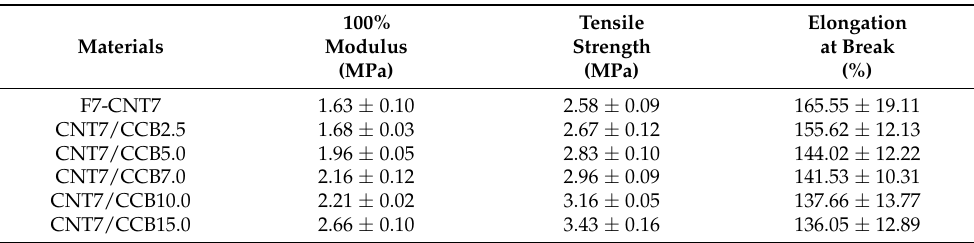
Table 3. Tensile properties in terms of 100% modulus, tensile strength and elongation at break of ENR-50 compounds with FeCl 3 (ENR–FeCl 3 ) filled with CNTs (F7-CNT7) and CNT–CCB hybrid fillers with various CCB loadings.